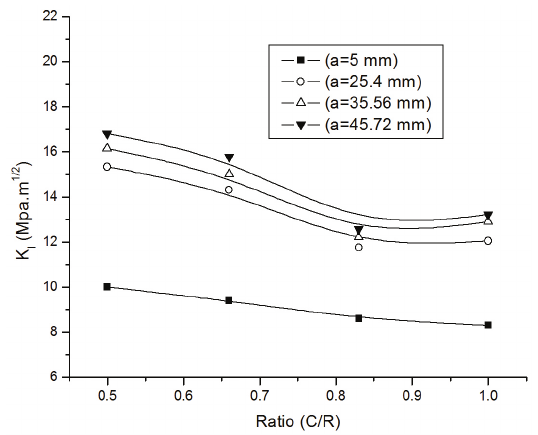
Figure 4. Variation of the SIF according to the ratio c/R for different crack length.